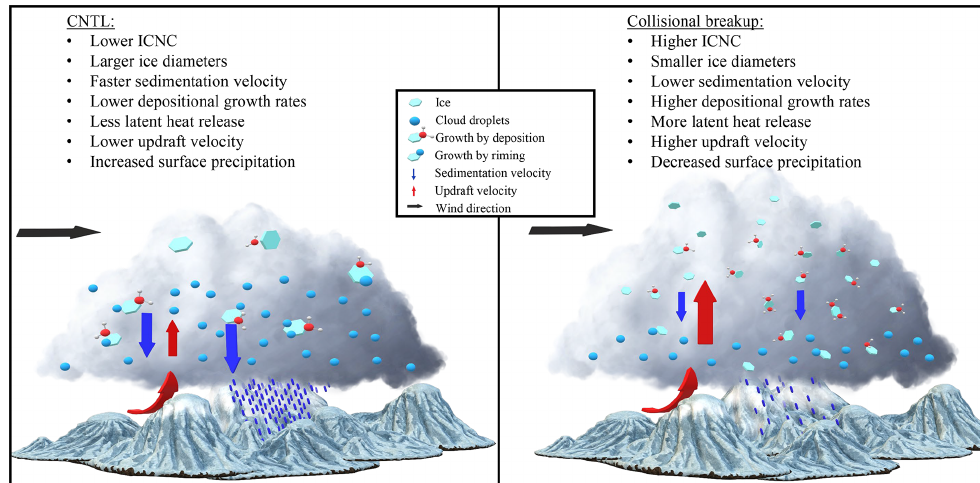
Figure 11. Schematic summary of the impact of collisional breakup of ice particles on the cloud structure and surface